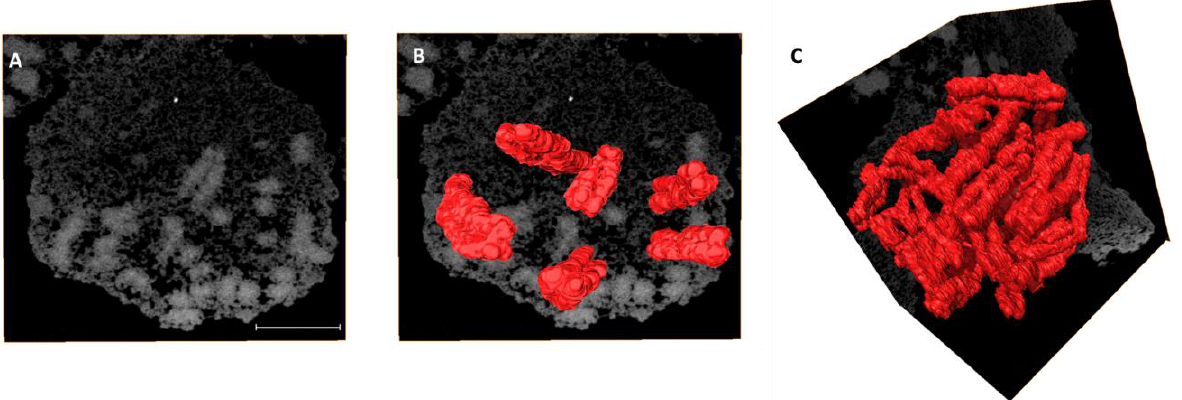
Figure 1. Volume reconstruction of individual human chromosomes from SBFSEM data. ( A ) A slice from an acquired SBFSEM stack of 345 backscattered electron (BSE) micrographs of a single prophase nucleus. Volume reconstruction of ( B ) 6 and ( C ) 46 chromosomes after segmentation. The pixel size of BSE micrographs is 11 nm × 11 nm and the sectioning thickness is 25 nm. Scale bar—2 µm.